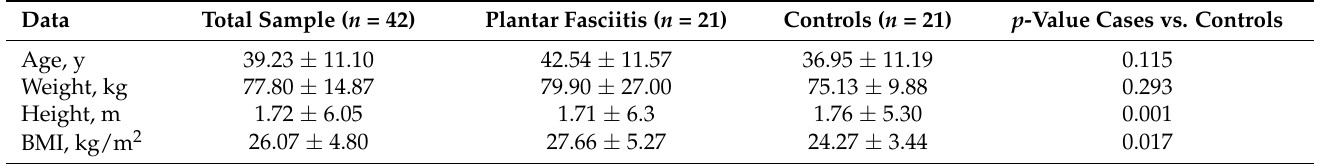
Table 1. Sociodemographic data of the